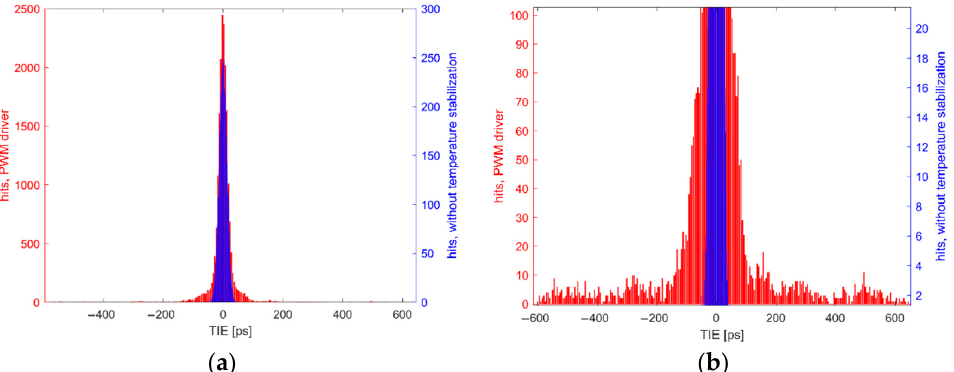
Figure 9. Distribution of TIE values ( a ) with and without temperature stabilization; ( b ) closeup on histograms tails.